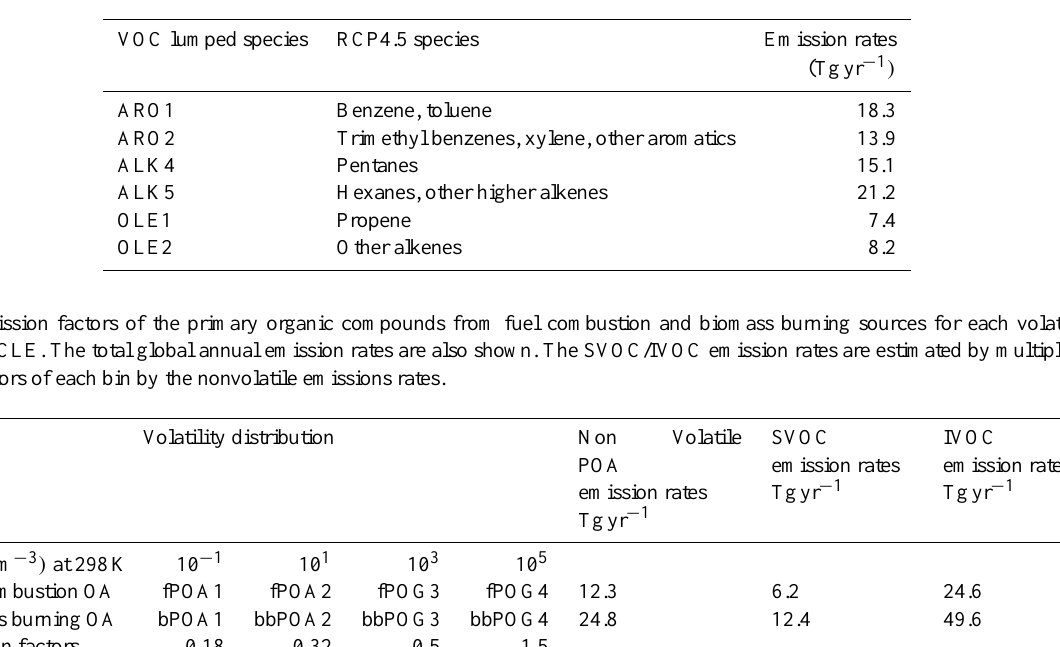
Table 3. Global annual emissions of the lumped anthropogenic VOC species introduced in the ORACLE module.